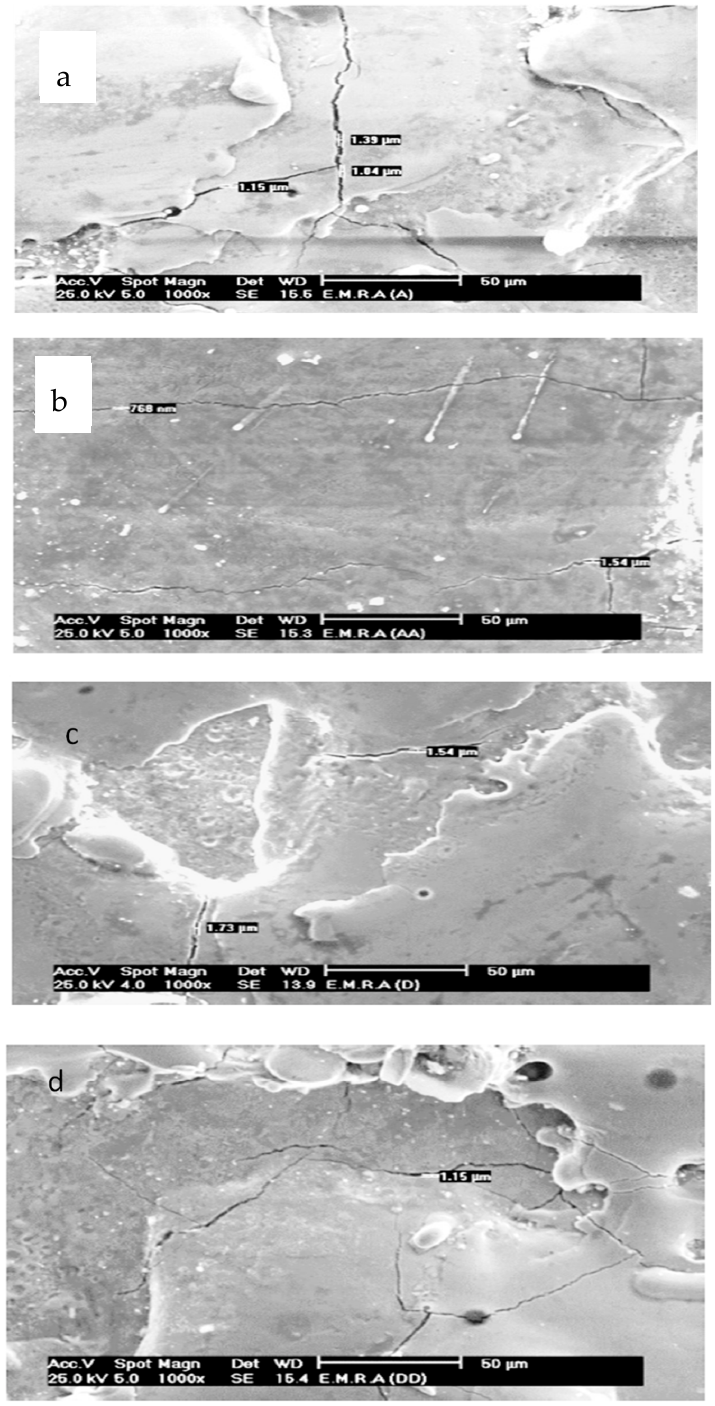
Figure 6. ( a ) Surface cracks of DIN 1.2379 rough machining using Dura graphite 11 electrode; ( b ) surface cracks of DIN 1.2080 rough machining using Dura graphite 11 electrode; ( c ) surface cracks of DIN 1.2379 rough machining using Poco graphite EDMC-3 electrode; ( d ) surface cracks of DIN 1.2080 rough machining using Poco graphite EDMC-3 electrode [182].